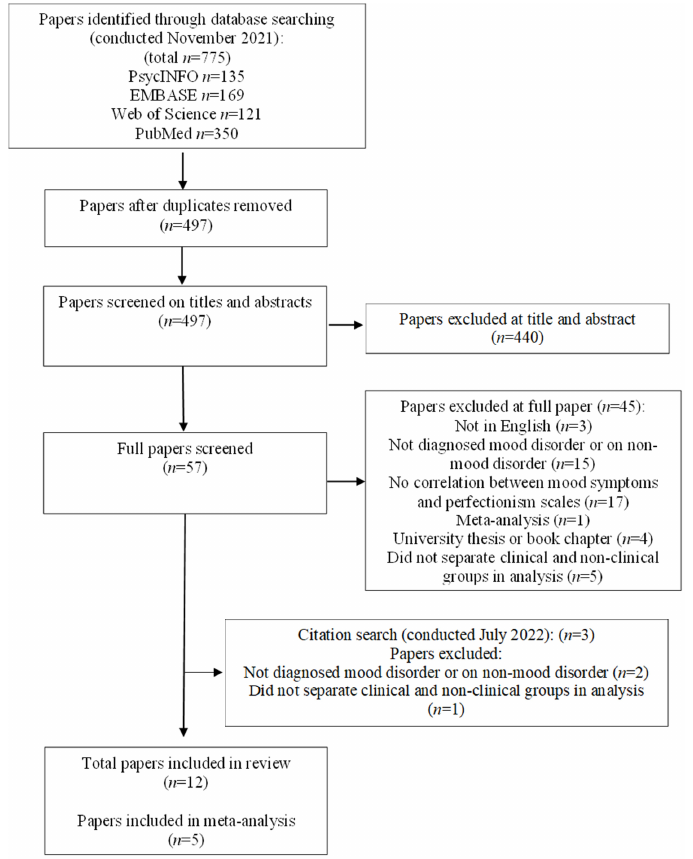
Figure 1. Flow Diagram of the systematic